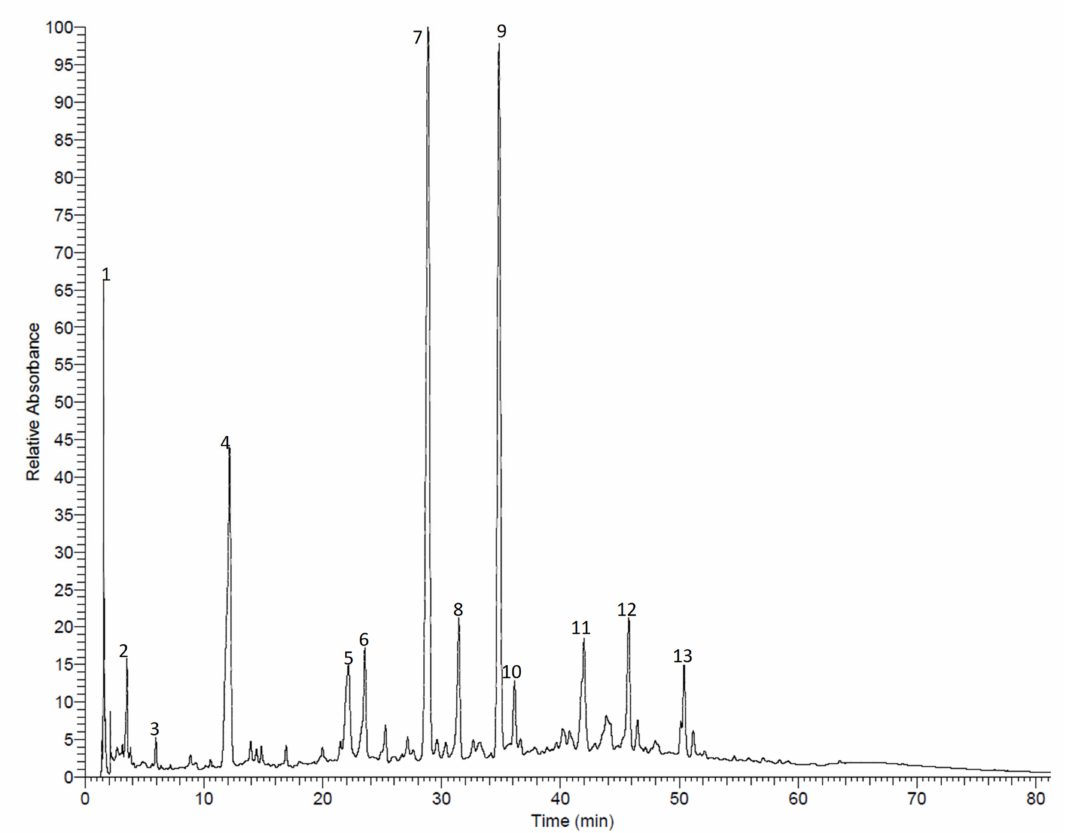
Figure 1. HPLC-PDA chromatogram of the methanol extract from A. anthelmintica leaf. ( 1 ) 3-Galloyl-glucose, ( 2 ) 2- galloyl-glucose, ( 3 ) gallic acid; ( 4 ) methyl gallate, ( 5 ) hydroxybenzyl- o -galloyl-glucose, ( 6 ) coumaroyl- o -galloyl-glucose, ( 7 ) quercetin- o -galloyl-glucoside, ( 8 ) quercetin glucoside, ( 9 ) kaempferol galloyl-glucoside, ( 10 ) kaempferol galactoside, ( 11 ) quercetin caffeoyl-glucoside, ( 12 ) quercetin coumaroyl-glucoside, ( 13 ) kaempferol coumaroyl-glucoside. The compounds were identified based on their molecular weights and mass fragmentation patterns, as reported before